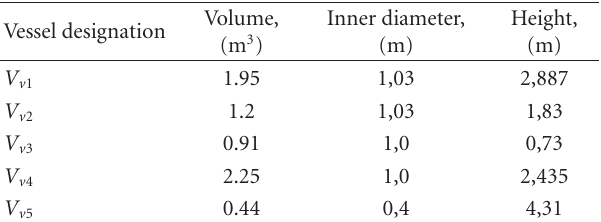
Table 2: Geometrical parameters of the high-pressure